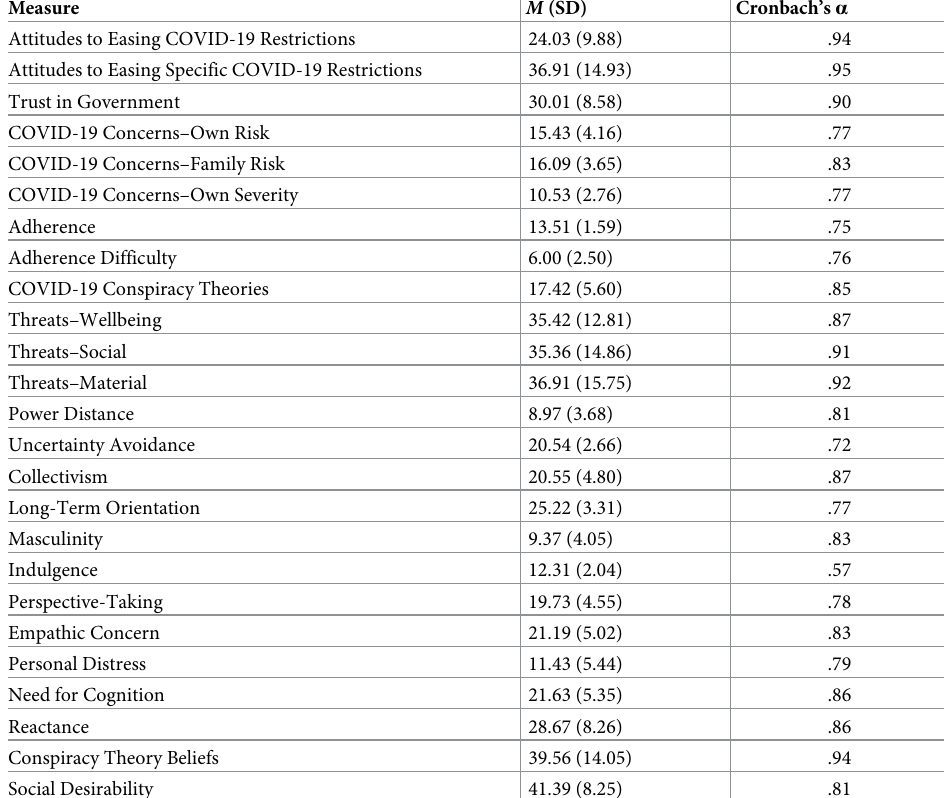
Table 8. Descriptive data for